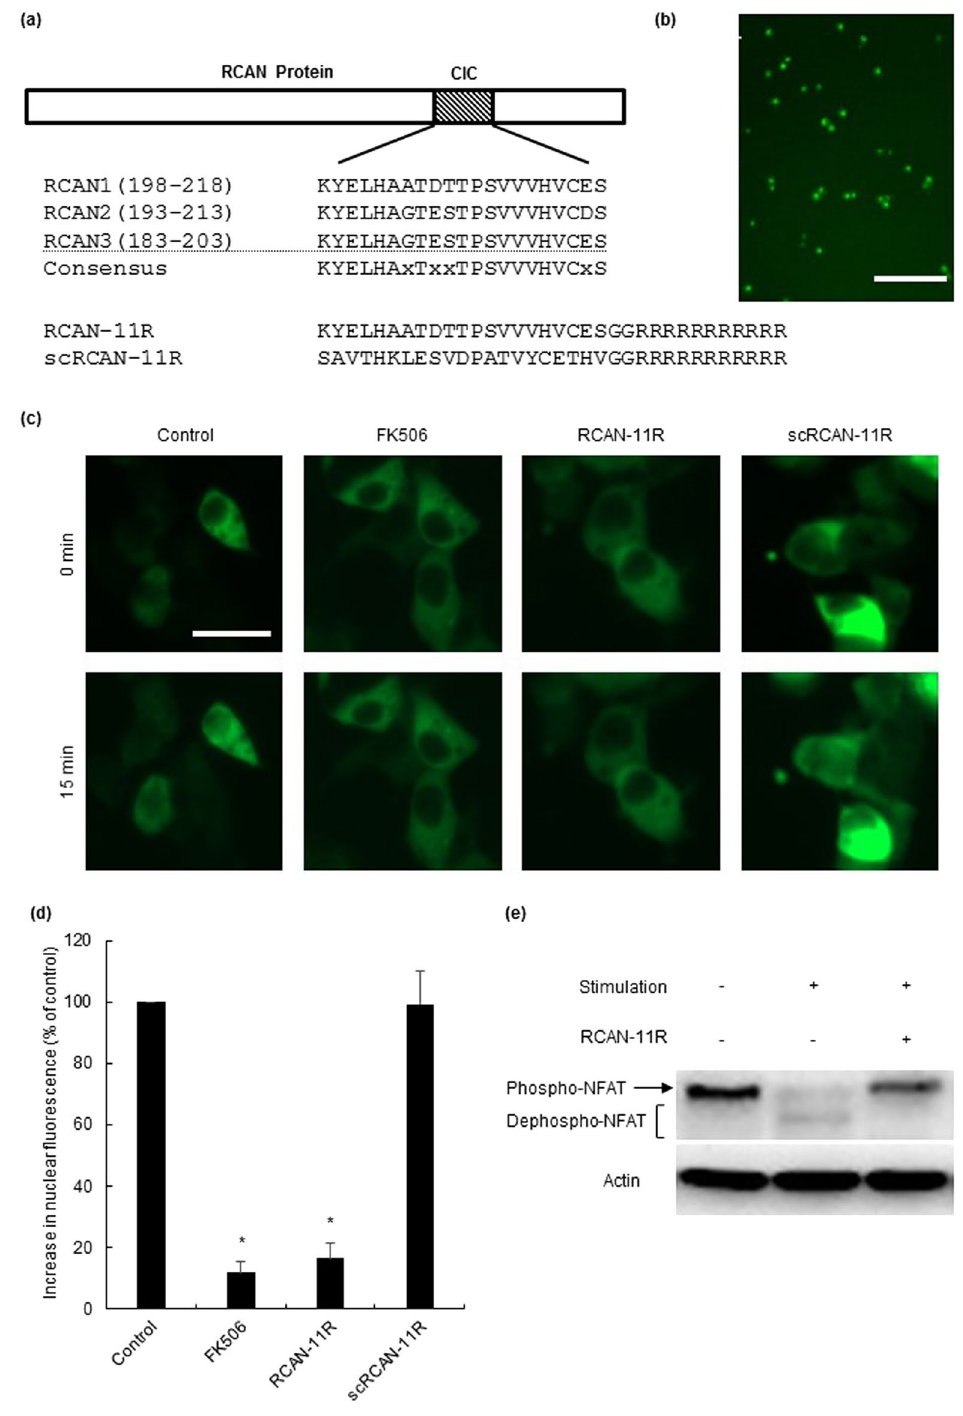
Figure 1. The transduction of RCAN-11R into lymphocytes and the inhibition of NFAT nuclear translocation. ( a ) The CIC (Calcineurin inhibitor of Calcipressin) motif of the human RCAN protein family (upper schematic illustration) and the sequence of RCAN-11R and the scramble RCAN-11R peptides (lower schematic illustration). ( b ) Transduction of RCAN-11R into lymphocytes. Jurkat cells were incubated with 10 μ M FITC- RCAN-11R and examined using an Olympus confocal microscope. Scale bar = 100 µ m. ( c ) The inhibition of NFAT nuclear translocation. HEK 293 cells that had been transfected with GFP-NFAT-1 plasmid were incubated with 1 μ M FK506 or 20 μ M RCAN-11R/scRCAN-11R for 2 h and then 500 nM ionomycin was added to the culture medium. Scale bar = 20 µ m. ( d ) The percentage of NFAT nuclear translocation. GFP-NFAT-1 nuclear translocation was quantified by microscopy. * p < 0.01 in comparison to control (no treatment). The values represent the mean ± SE of five independent experiments. ( e ) Western blot of phosphorylated NFAT1 (Phospho-NFAT) and the faster-migrating dephosphorylated forms